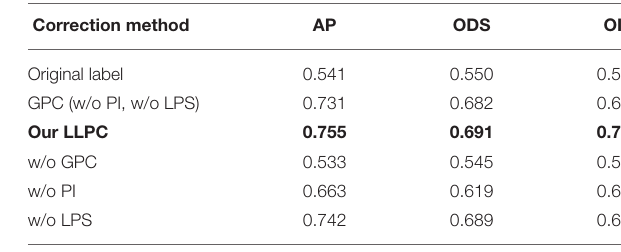
TABLE 5 | Ablation of our LLPC. “GPC” is gradient-guided point correction.